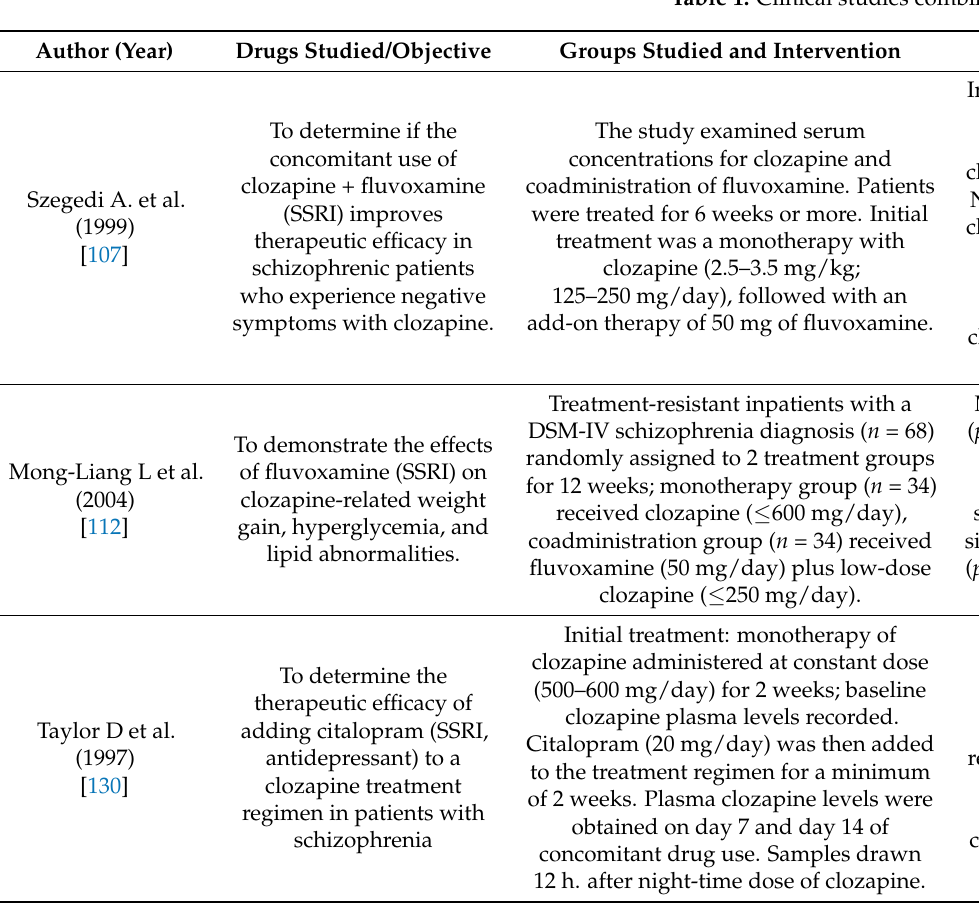
Table 1. Clinical studies combining clozapine with